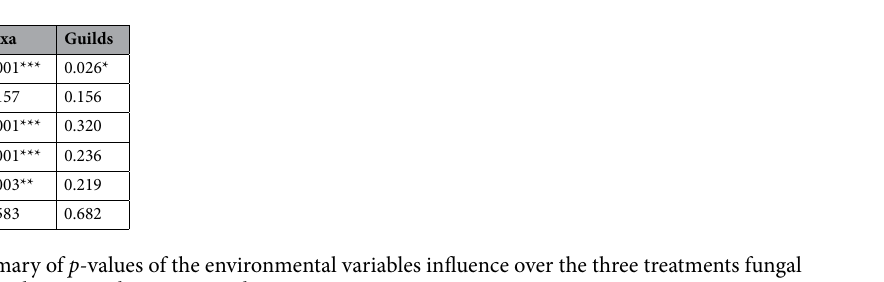
Figure 3. Non-metric multidimensional scaling (NMDS) of total fungal taxa ( A ) and trophic guilds ( B ) in soil samples collected 9 years after scrublands were subjected to fuel-reduction treatments. Treatments: control (dark green), burned (dark gray), cleared (brown). Ellipses represent the distribution of the fungal community related to the treatment. Isolines of the gradient of the C content ( B ) were also plotted on the NMDS ordinations using the ordisurf Model Gaussian function.